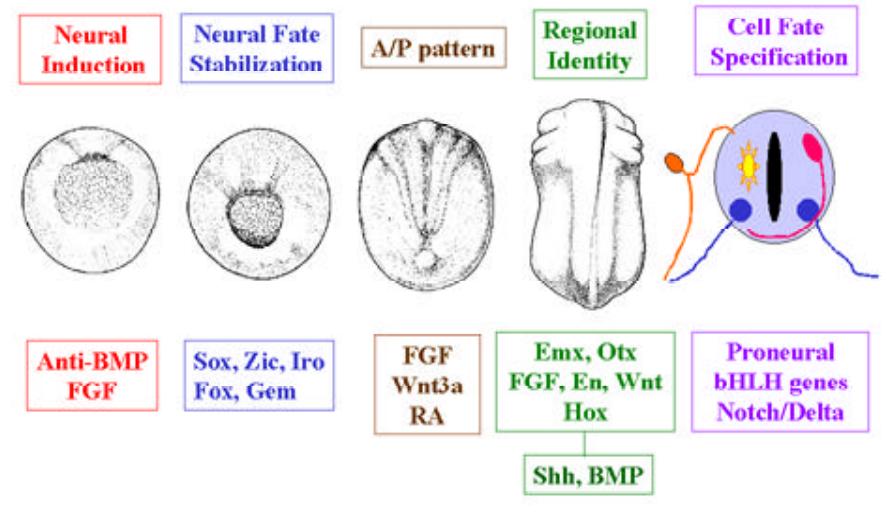
FIGURE 1. The developmental program that converts ectoderm to a patterned neural tube, called neural specification, can be divided into several steps. These are named across the top of the panel. Some of the proteins involved in these early steps are boxed along the bottom of the panel. In the middle are representative stages of Xenopus development at which these steps are evident, i.e., stage 10 (early gastrula) for neural induction, stage 12 (late gastrula) for neural fate stabilization, stage 13/14 (neural plate) for initial anterior/posterior (A/P) patterning, and stage 23 (closed neural tube) for brain region identity. For the step of cell fate specification, a cross-section of the spinal cord is diagrammed, with different cell types beginning to differentiate (motoneurons, blue; primary sensory neurons, orange; interneurons, red; glia; yellow). Drawings of Xenopus embryos from